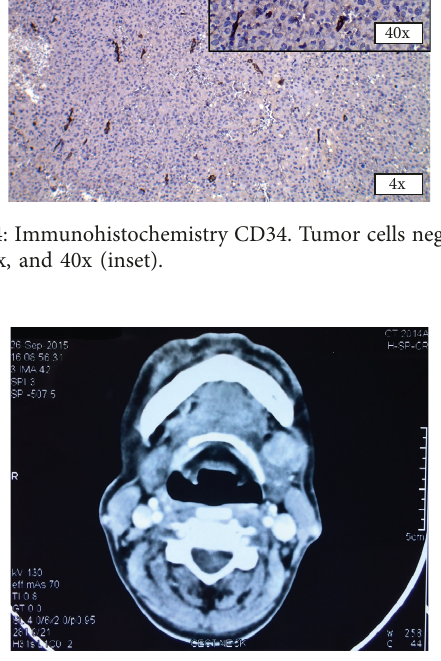
Figure 5: Contrast-enhanced computed tomography. CECT axial section shows ill-defined heterogeneously enhancing soft tissue lesion in the left submandibular region with no obvious bone erosion. Few subcentimetric nodes are seen along bilateral sub- mandibular and upper jugular chains.